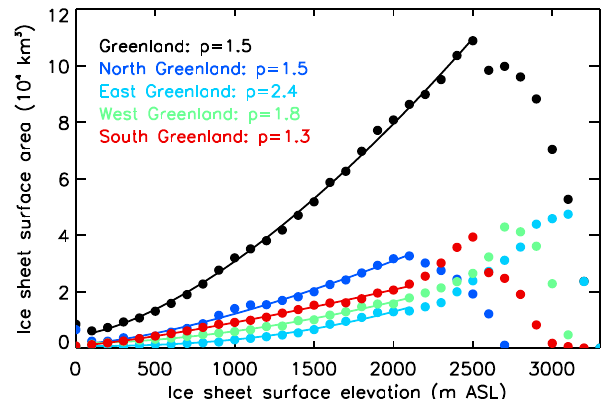
Figure 8. Area per 100m elevation bin of the Greenland ice sheet for the entire ice sheet (black dots), and subsections (colored dots). Lines represent the least-squares power-law fits. Note that a linear slope yields p =